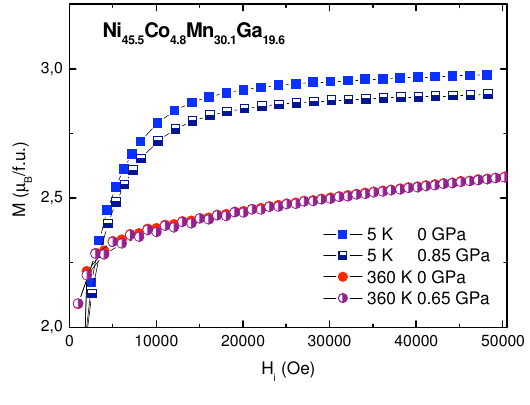
Fig. 3. Magnetization isotherms of martensite ( at 5 K) and austenite (at 360 K) phases of ‘5-30’ alloy under pressure.